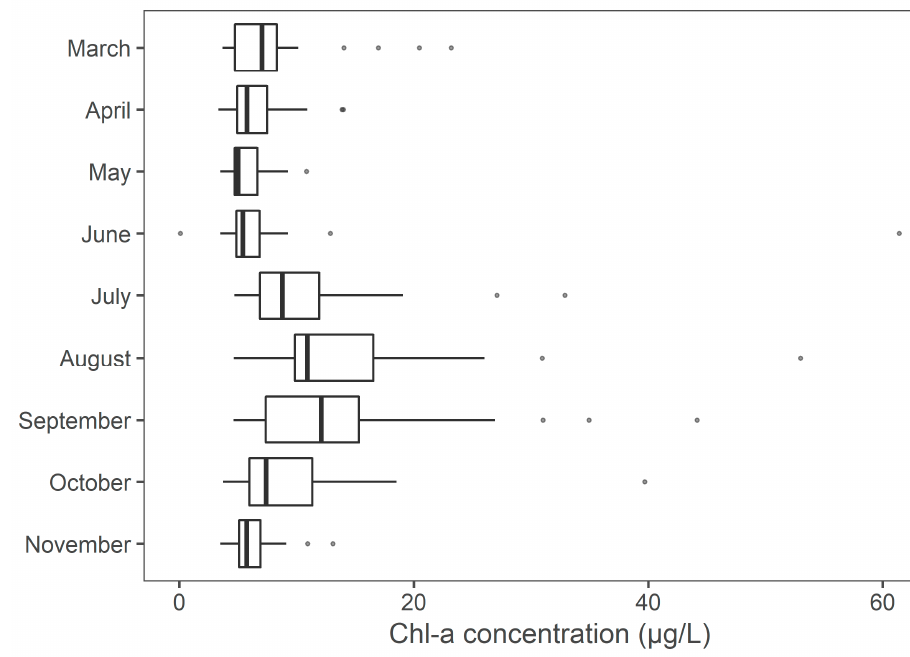
Figure 17. Distribution of whole-lake median values by month.